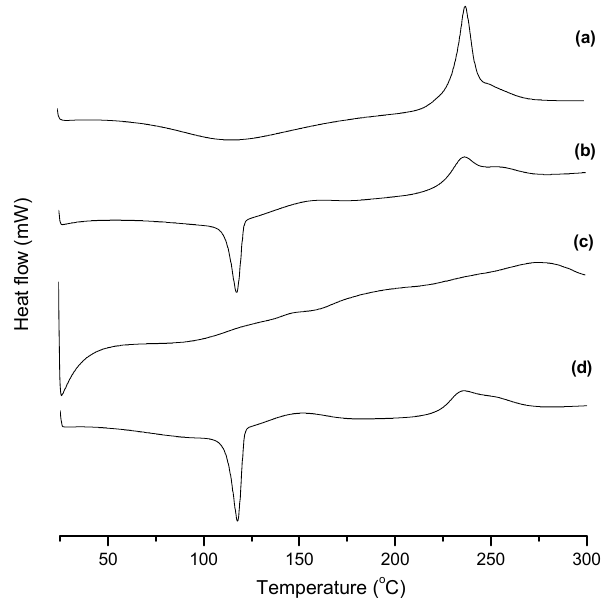
Figure 7. DSC thermograms of ( a ) Pristine HA, ( b ) HA gel, ( c ) NSP and ( d ) HA-NSP, measured from 25 °C to 300 °C.